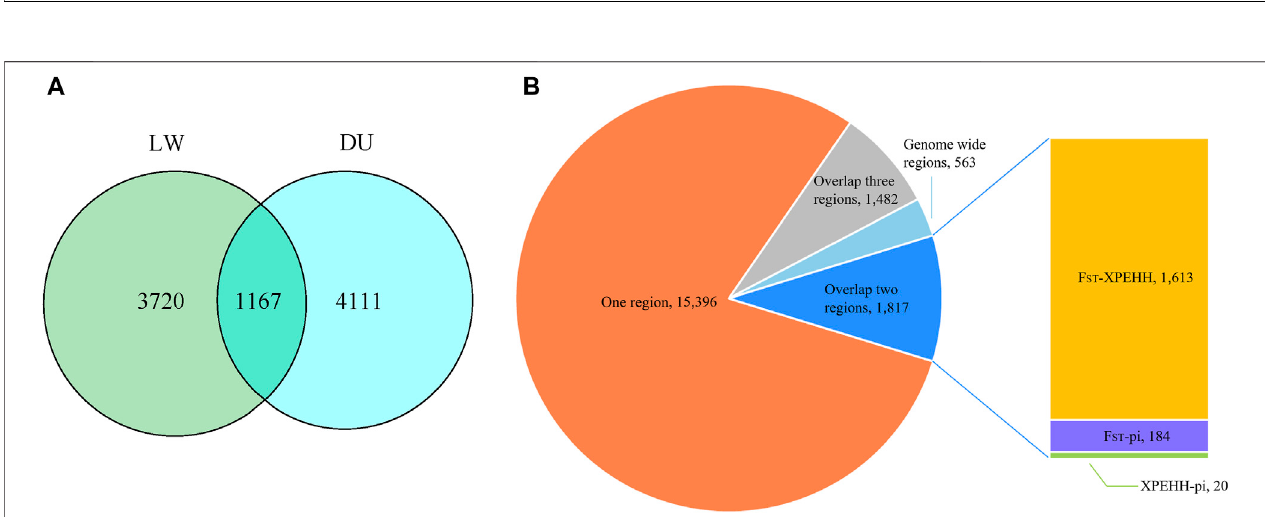
FIGURE 5 | (A) Venn diagram shows the overlap in the number of candidate regions detected by different populations. The left circle represents the numbers of candidate regions detected by more than two methods between Beijing Black pig and Large White. The right circle represents the numbers of candidate regions detected by more than two methods between Beijing Black pig and Duroc. (B) The number of SNPs with high Δ AF in each region between Beijing Black pig and other two breeds.